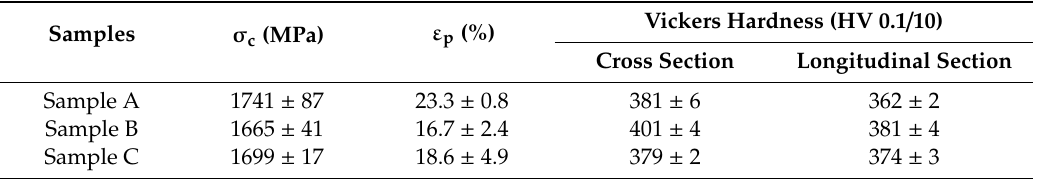
Figure 8. Compressive stress – strain curves of the compression testing for SLM-produced Ti-6Al-4V samples with different build orientations. Table 5. Results of mechanical tests of SLM-produced Ti-6Al-4V samples with different build